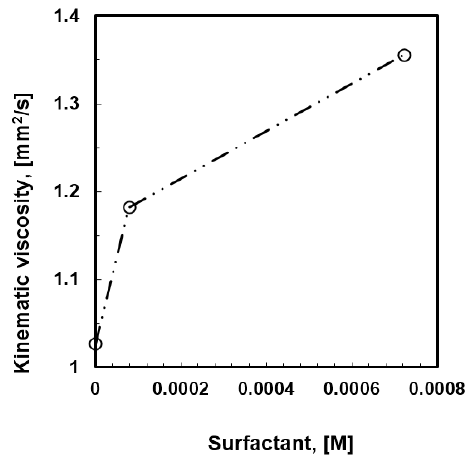
Figure 3. Effects of the surfactant loading on the kinematic viscosity of the PSU/DCM/2-propanol (12 wt %) solutions.